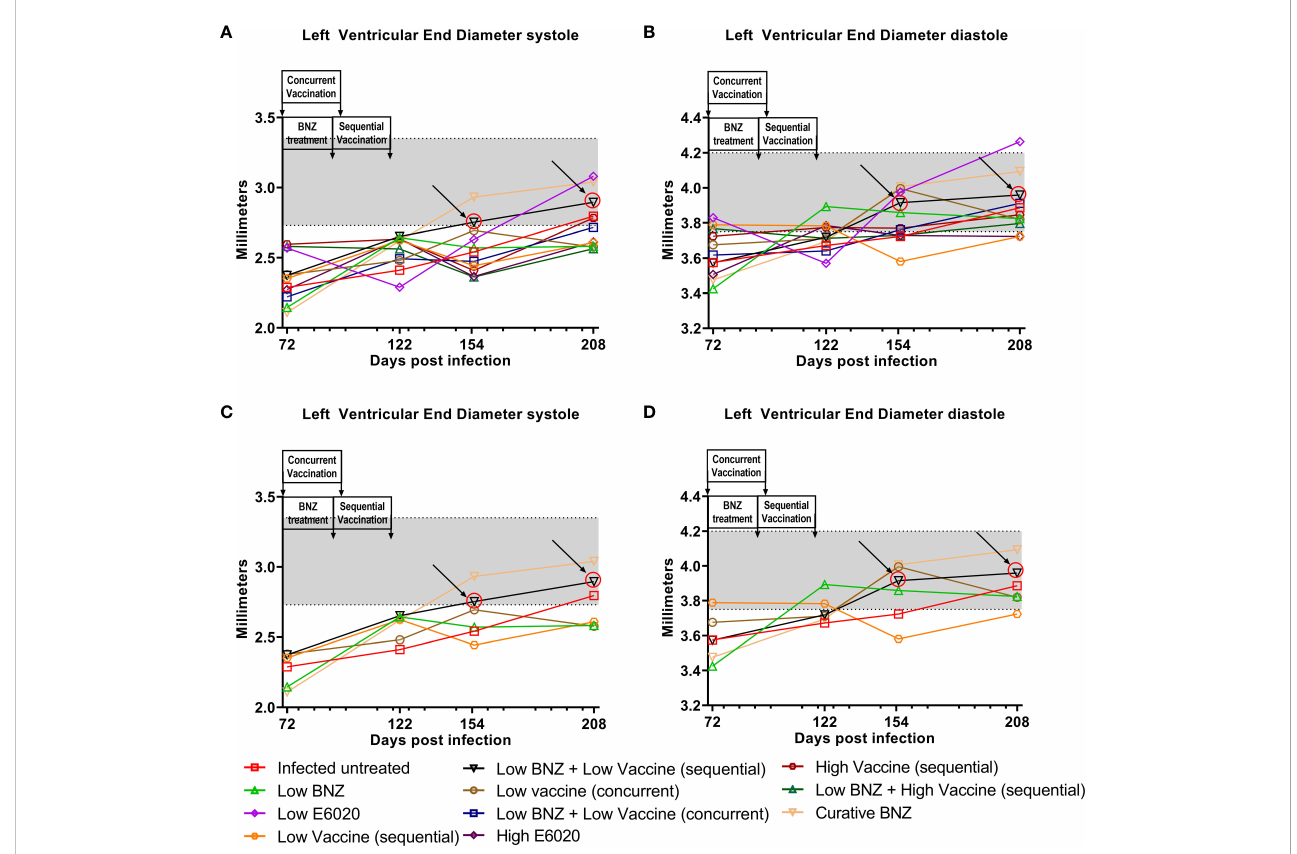
FIGURE 4 Left Ventricular End diameter (LVED) after treatment. M-mode images from echocardiographic examination were used to measure LVED in naïve, infected untreated and treated mice at 70dpi, 122dpi, 154dpi and 208dpi during both systole (A) and diastole (B) . Panels (C) and (D) illustrate only a subset of treatment groups to better visualize treatment differences between key groups. The grey shaded area represents the mean ± SD of the LVEDs and LVEDd measurement from naïve age matched